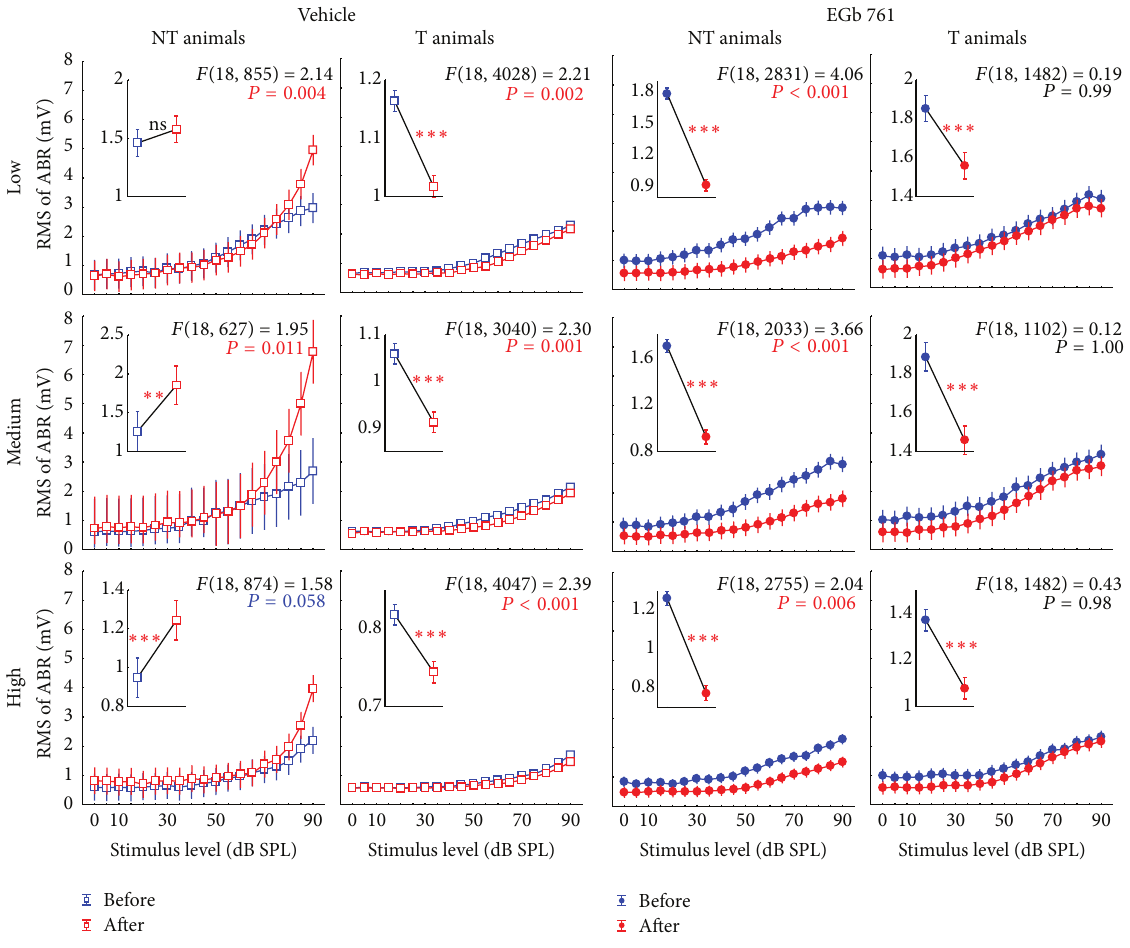
Figure 12: Level functions of the auditory brainstem responses (ABR) in NT and T animals grouped for vehicle and EGb 761 treated groups. Given are the mean root mean square (RMS) values of the ABR amplitudes ( ± 95% confidence intervals) as a function of stimulus level before (blue) and after trauma (red) for the four subgroups for low (0.5 to 1.4kHz), medium (2.0 to 4.0 kHz), and high stimulation frequencies (5.6 to 16.0 kHz). The 𝐹 -statistics of the 2-factorial ANOVAs are shown for each panel and the corresponding 1-factorial part grouped for time of measurement (pre versus post trauma) is given in each inset (also with the RMS of ABR in mV) with the asterisks indicating the significance level (ns = not significant, ∗∗ 𝑃 < 0.01 , ∗∗∗ 𝑃 < 0.001